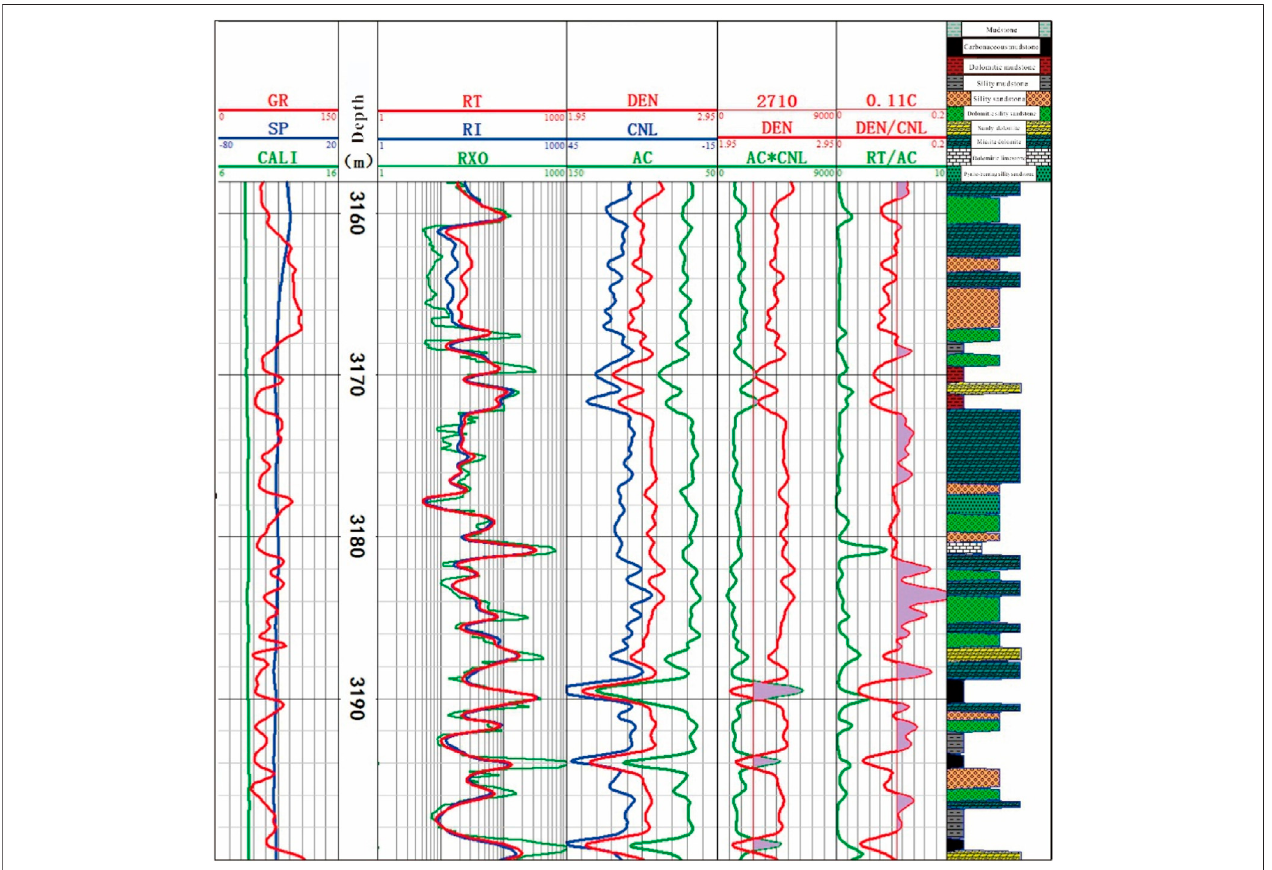
FIGURE 6 | Lithology classi fi cation of Well